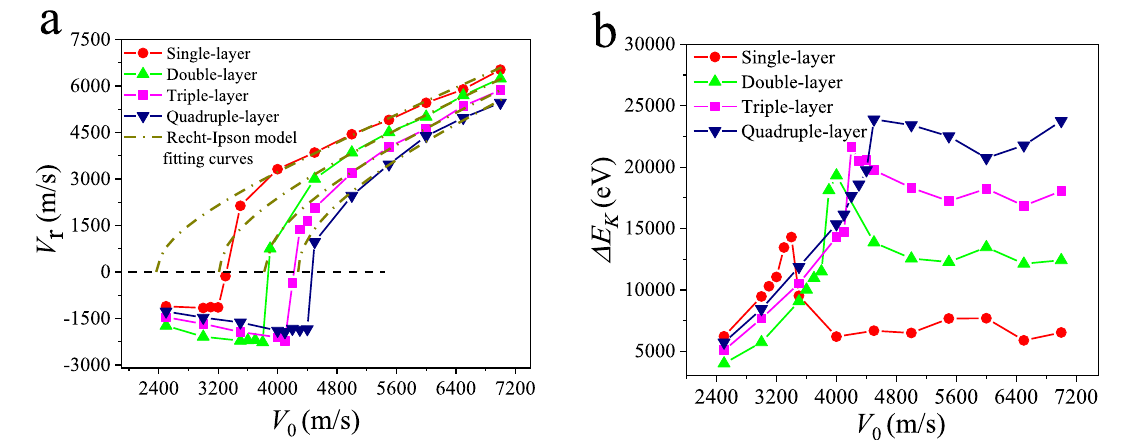
Figure 1. Residual velocity V r ( a ) and kinetic energy loss Δ E k ( b ) as a function of the initial impact velocity V i of the projectile collided with single/multi-layer graphene, ranging from 2500 to 7000 m/s. The dashed dot line represents theoretical prediction from the continuum Recht–Ipson model. The minus symbol (−) of the residual velocity denotes the restitution process whereas the plus symbol (+) represents the penetration